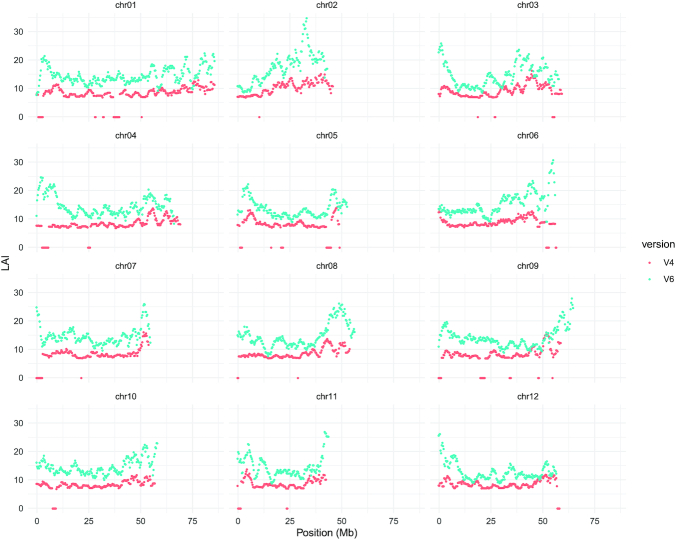
Genome-wide LTR Assembly Index (LAI) [38] scores for DM assembly v.4.04 (V4) and v.6.1 (V6). LAI was calculated for 3-Mb sliding windows with a 300-kb step size.